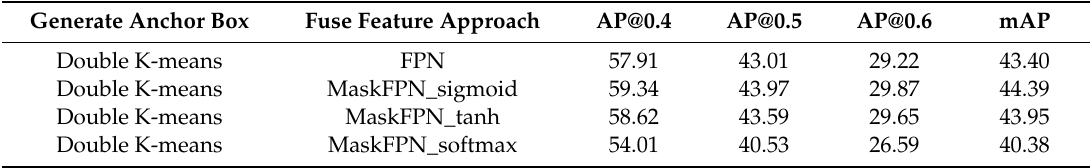
Figure 9. Performance of MaskFPN in the training phase. Table 4. Comparison of MaskFPN and FPN (%).